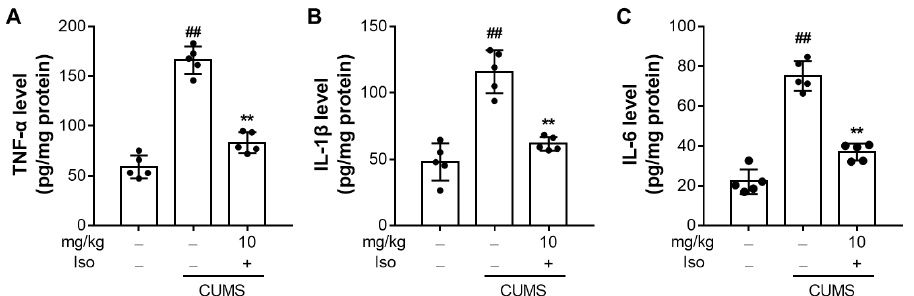
Figure 7. Isofraxidin suppresses CUMS-induced increased expression of pro-inflammatory cytokines. Levels of TNF- α ( A ), IL-1 β ( B ), and IL-6 ( C ) in the hippocampus were determined by ELISA and normalized to protein levels. Data are presented as means ± SEM ( n = 5). The Control group was CUMS-free mice administered with normal saline. CUMS group was CUMS mice. Significance was analyzed by one-way ANOVA followed by the Bonferroni correction. ## p < 0.01, compared with the control group. ** p < 0.01, compared with CUMS group.